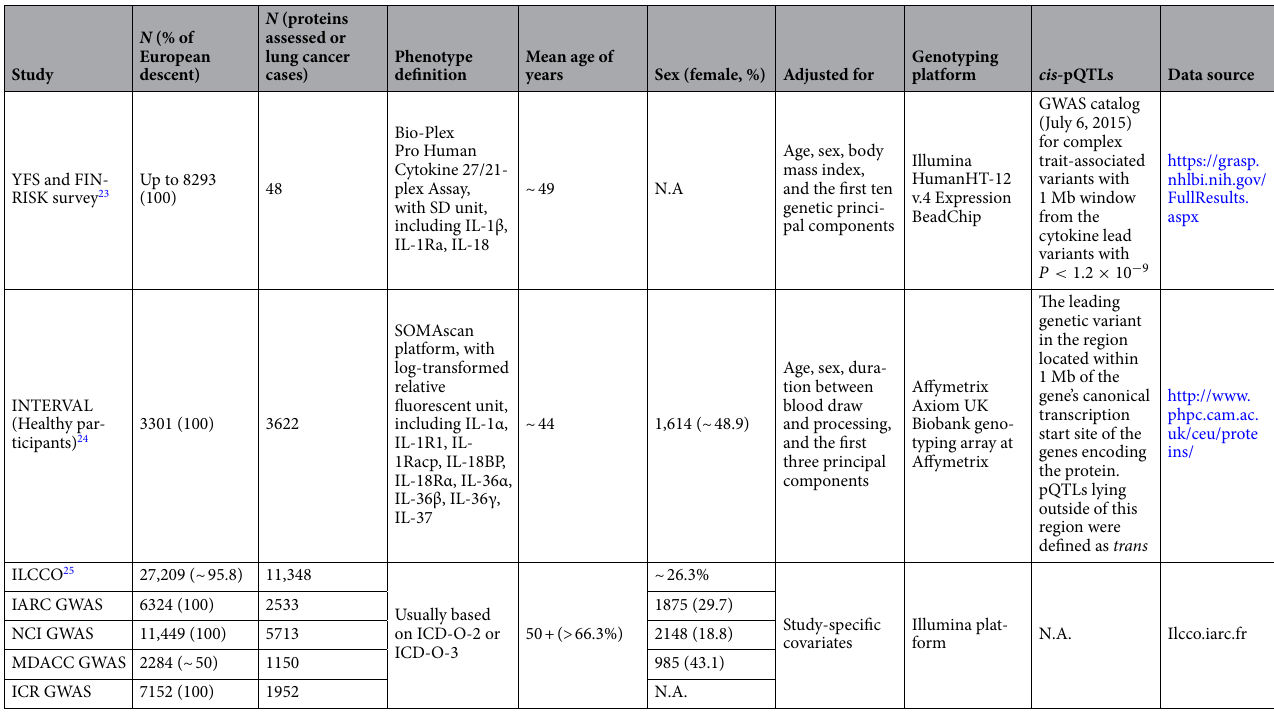
Table 1. Study details for the two genome-wide association studies (GWAS) for proteomics and the International Lung Cancer Consortium (ILCCO) study. GWAS genome-wide association study, NA